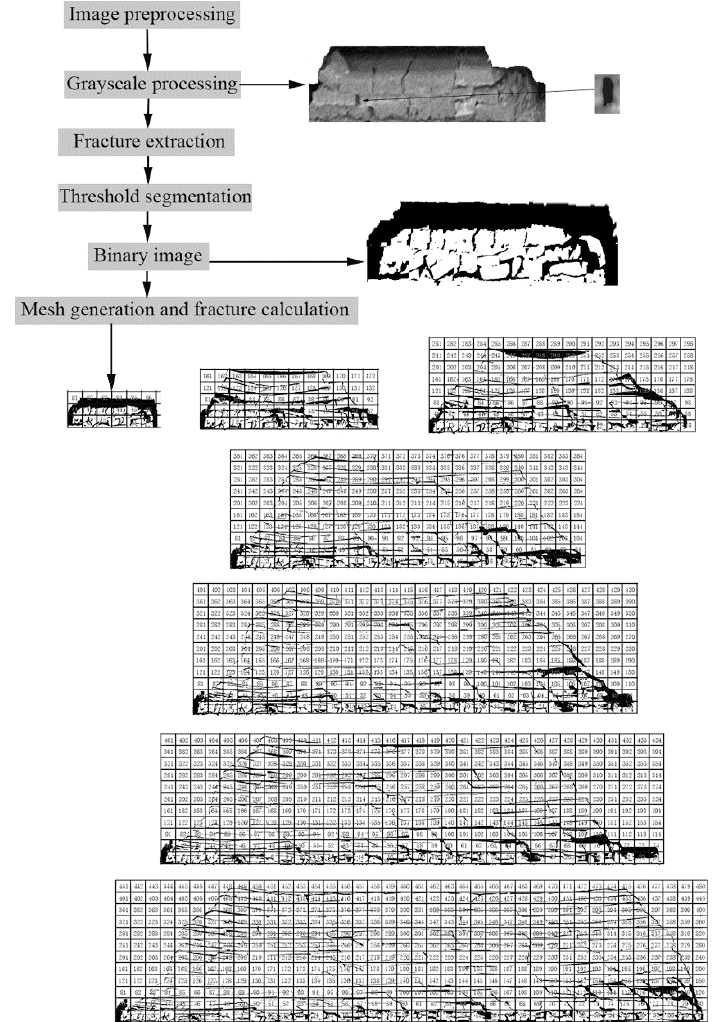
Figure 4. Flow chart of extraction of fracture images and variations in the fracture network due to mining.